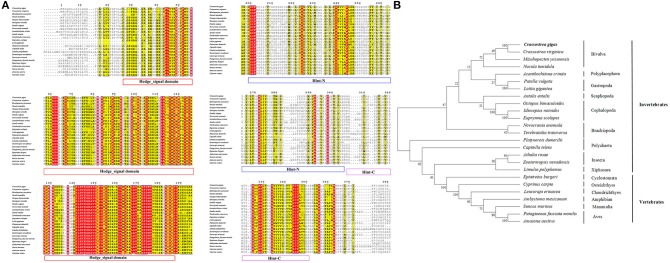
(A) Multiple sequence alignment of the CgHh amino acid sequence among species. The conserved functional structure are marked in box. Identical residues are shown as white letters with red background, and similar residues are shown as black letters with yellow background. (B) Neighbor-joining phylogenetic tree based on the amino acid sequences of the CgHh.